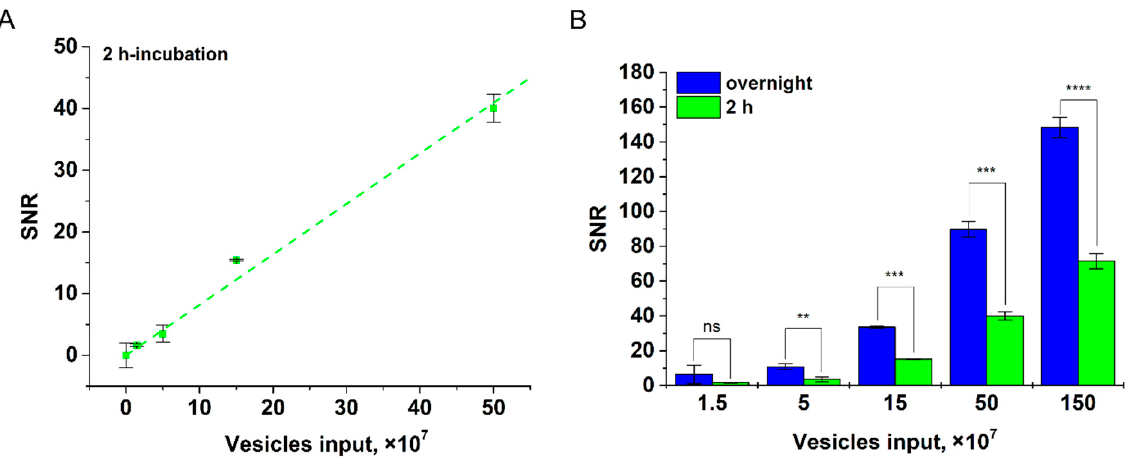
Figure 6. Detection of CD81 + /CD9 + HT29 EVs at various incubation times. ( A ) Linear fitting plot at 2 h incubation. ( B ) Dependences of SNR upon incubation time (2 h and overnight) with different HT29 EV inputs; statistical significance determined using the unpaired two-tailed Student’s t -test is denoted by asterisks (ns— p > 0.05, **— p < 0.01, ***— p < 0.001, ****— p < 0.0001).